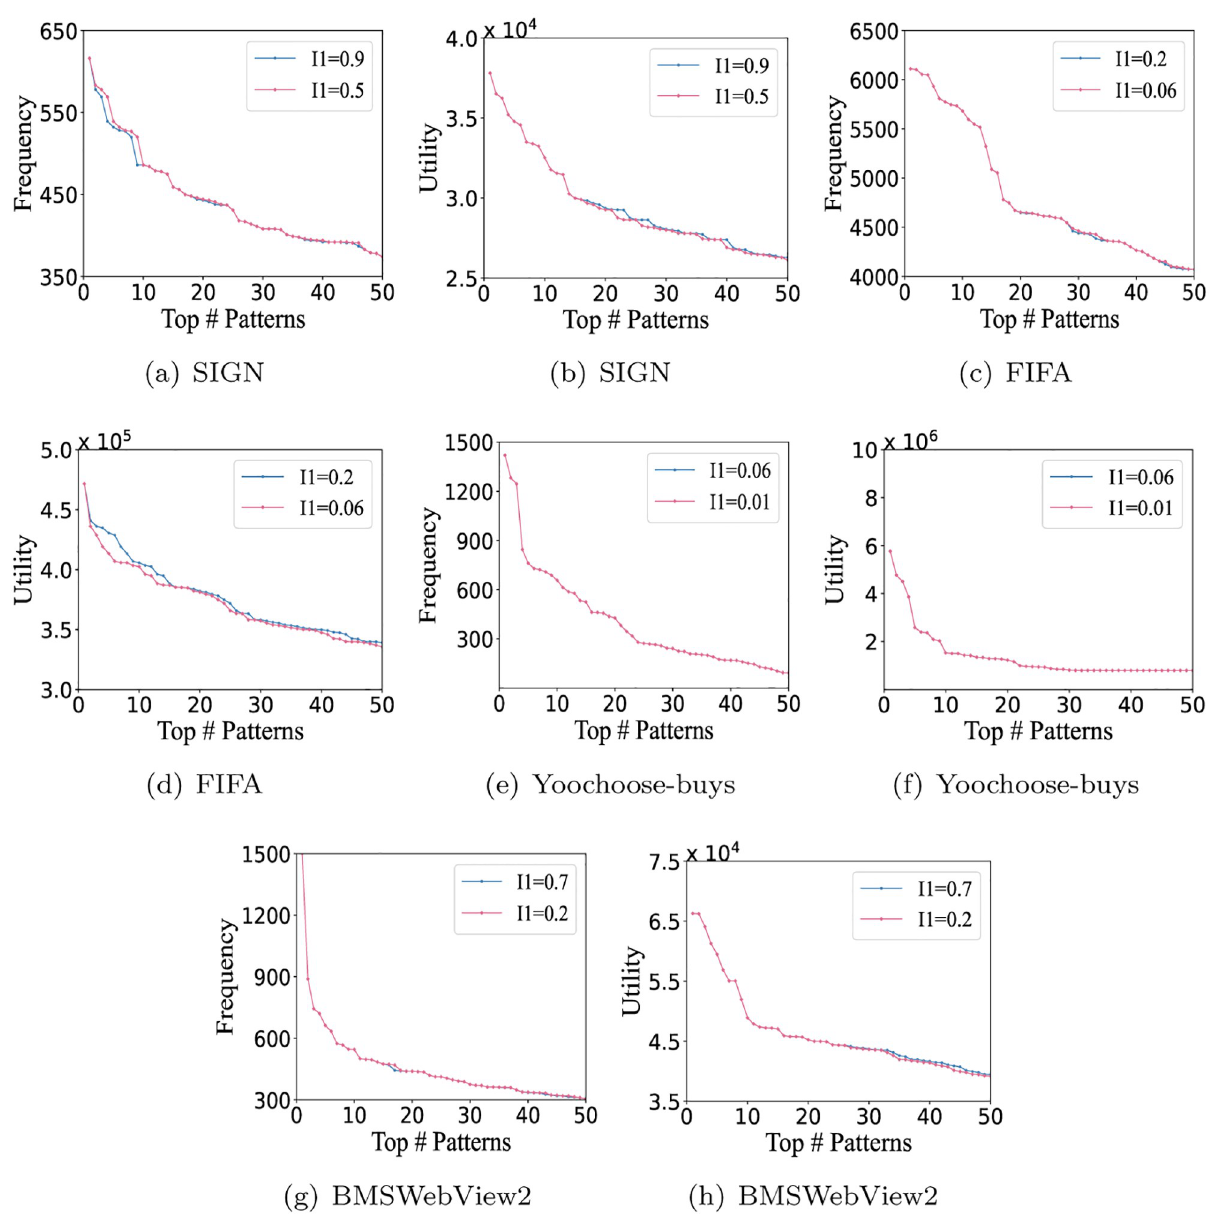
Fig 9. The influence of I 1 . (a) SIGN, (b) SIGN, (c) FIFA, (d) FIFA, (e) Yoochoose-buys, (f) Yoochoose-buys, (g) BMSWebView2, (h) BMSWebView2, (i) SynDataset-40K, (j) SynDataset-40K, (k) SynDataset-160K, and (l) SynDataset-160K.